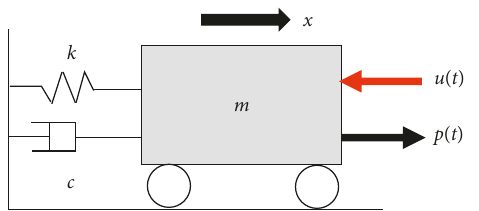
Figure 9: Diagram of a single degree of freedom for rigid motion of a bridge with the